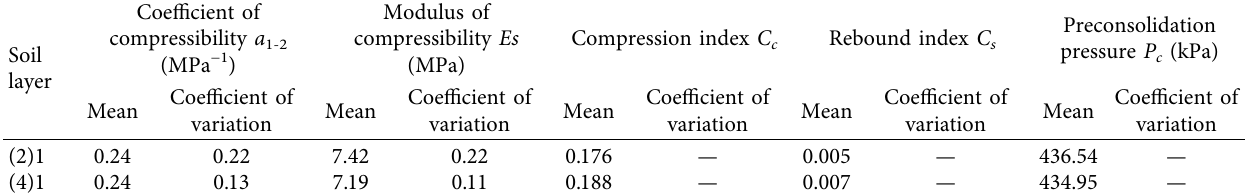
Table 3: Soil deformation